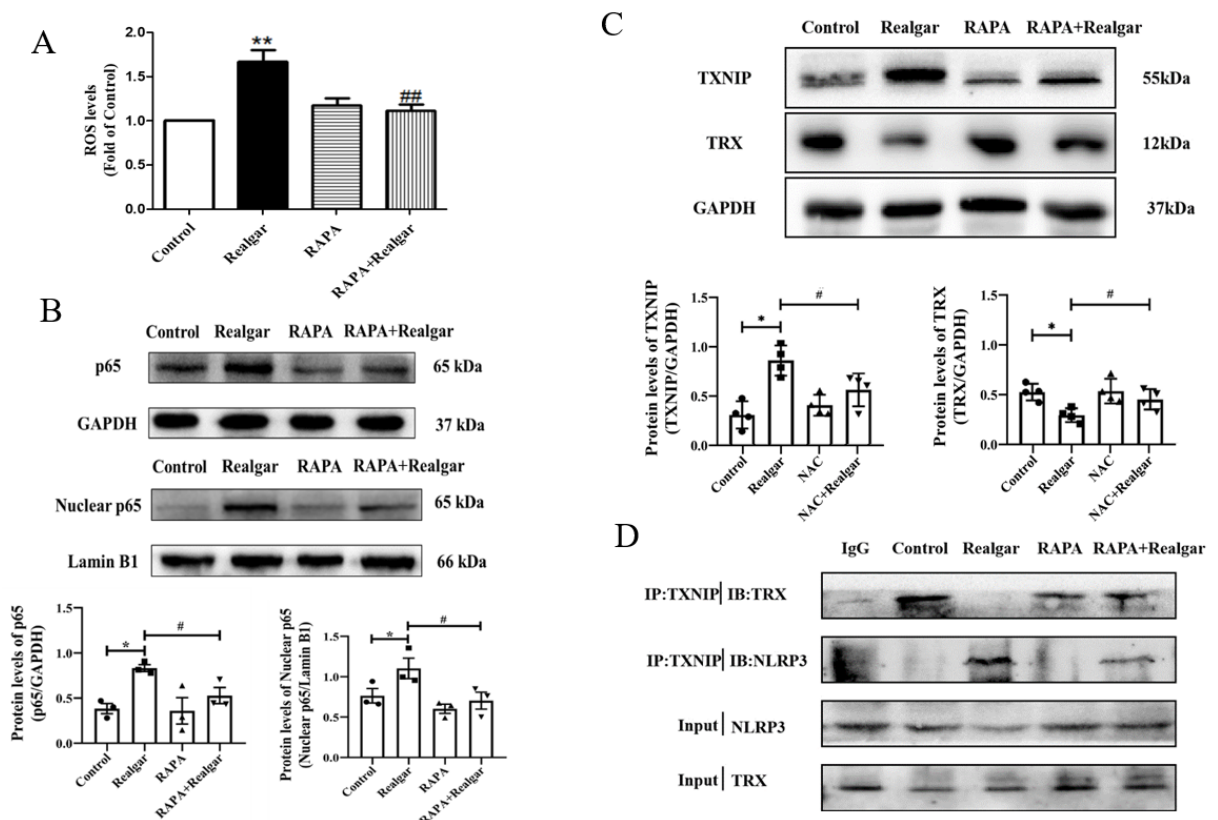
Figure 6. Autophagy eliminates excessive ROS, inhibits NF- κ Bp65 nuclear translocation and down- regulated TXNIP/NLRP3 axis in realgar exposed mouse livers. ( A ) The effect of RAPA on ROS level in realgar-exposed mouse livers ( n = 6). ( B ) Representative Western blots and quantitative analysis of the expressions of total NF- κB p65 and Nuclear -NF- κB p65 in RAPA treated groups. The gray value of the bands was normalized to GAPDH ( n = 3). ( C ) Representative Western blots and quan- titative analysis of the expressions of TXNIP and TRX in RAPA treated groups. The gray value of the bands was normalized to GAPDH ( n = 3). ( D ) Immunoprecipitation and immunoblot analysis of the interaction between TXNIP and TRX, TXNIP and NLRP3 in mouse livers in RAPA treated groups. Data are presented as mean±SEM. * p < 0.05, ** p < 0.01, compared with control group; # p < 0.05, ## p < 0.01, compared with realgar-treated group.